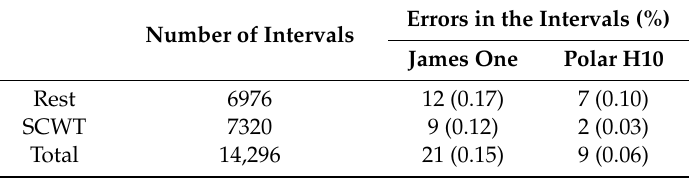
Table 1. The number of intervals obtained using both devices during the required tasks and errors detected using the developed